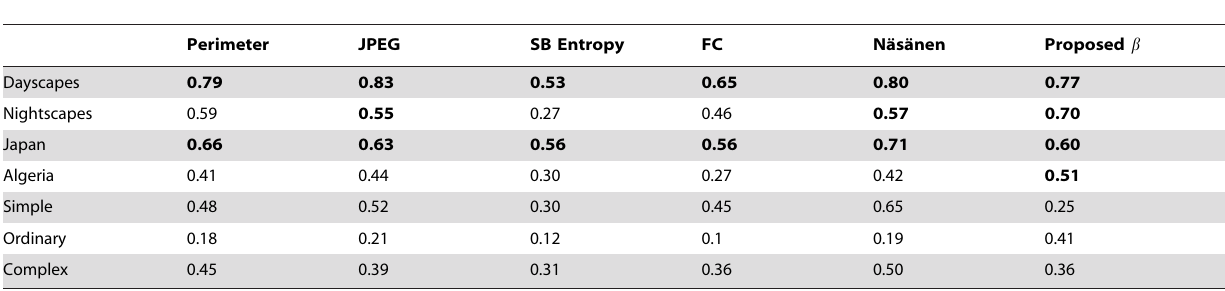
Table 1. Correlation coefficients between objective and subjective ranks for individual streetscape